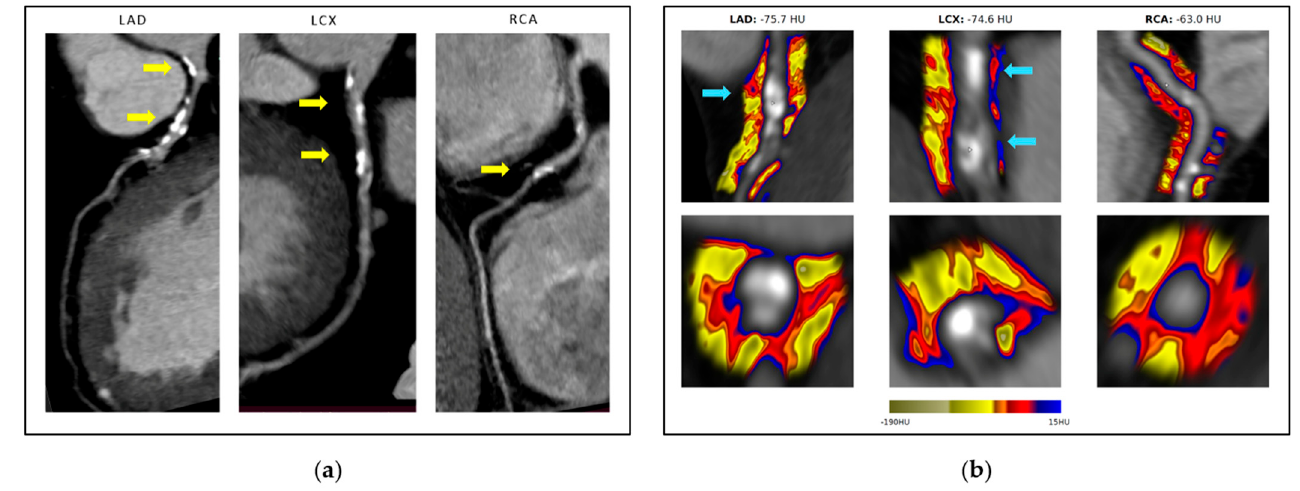
Figure 1. Conventional CCTA image of the three major coronary arteries ( a ) and a colored mapping representation of an abnormal FAI for the same patient ( b ). Figure shows CCTA images of the three major coronary arteries with a stable atherosclerotic lesion (yellow arrows) in a patient who had a COVID-19 infection a few months prior to CCTA examination ( a ) and delineated pericoronary fat with the FAI colored mapping around the non-culprit lesions (blue arrows) demonstrating abnormal FAI in the same patient ( b ). Using the CaRi-Heart ® v2.4.2 platform (panel b ), FAI-Score was evaluated for each individual at baseline in the proximal LAD, LCX, and RCA.